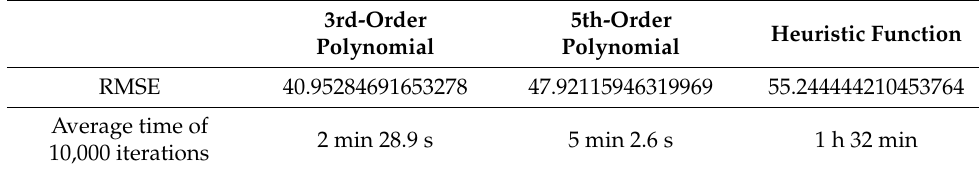
Table 3. Program operation